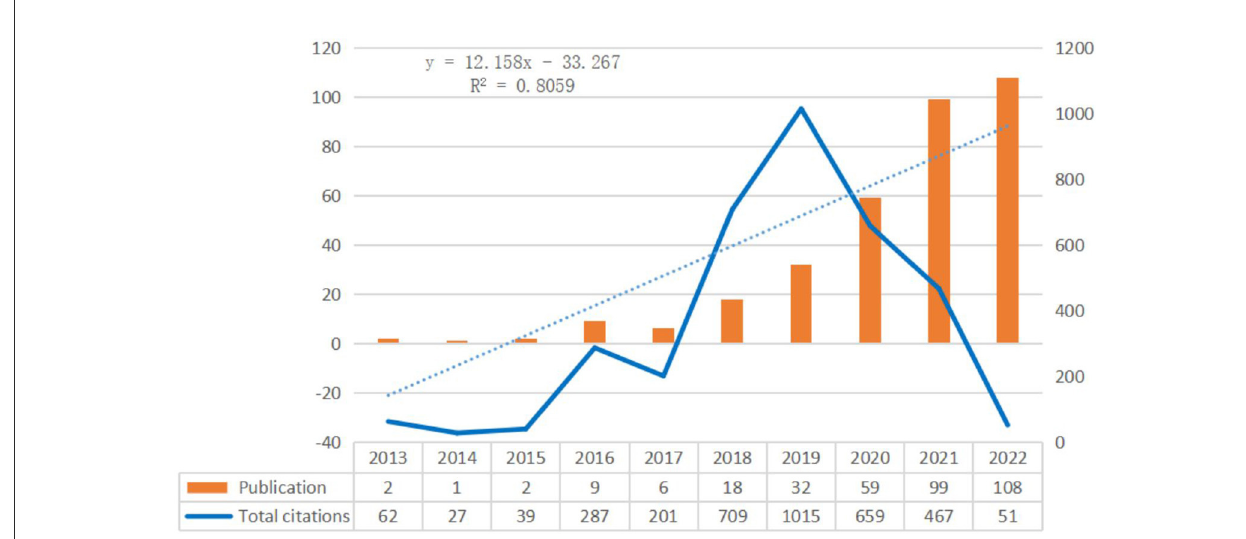
FIGURE2 Trends in publications and citations of machine learning related AKI research.